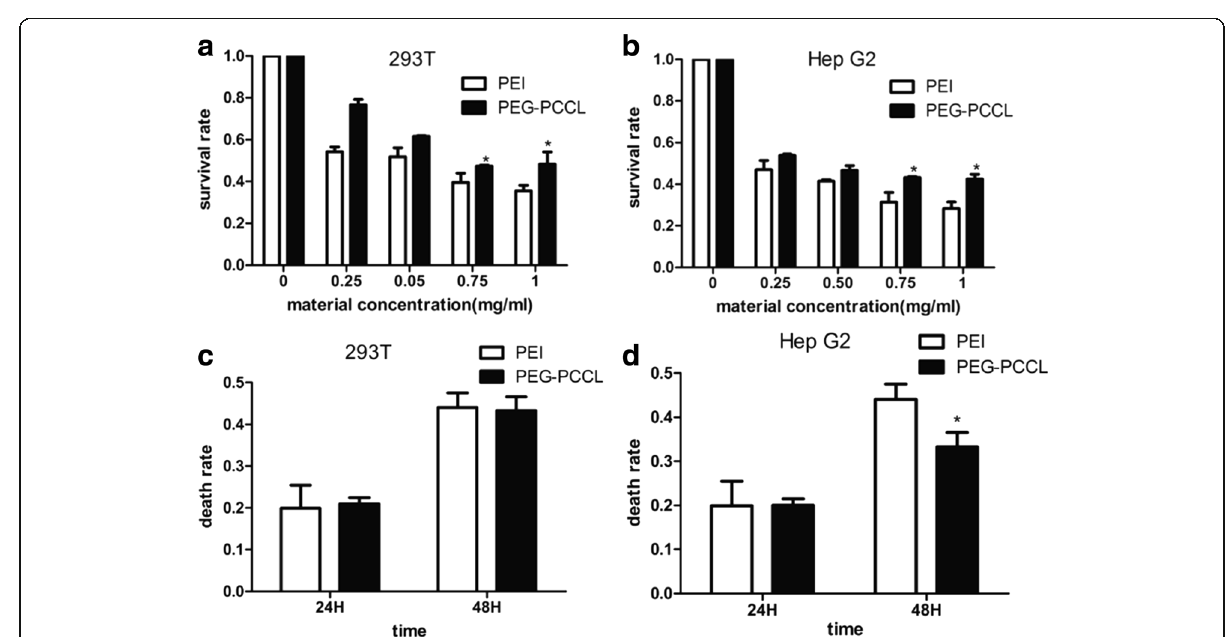
Fig. 3 The cytotoxicity of PEG-PCCL compared with PEI. a , b MTT assay showed the survival rate of 293 T and HepG2 concentration dependently compared with negative controlled group(PEI). c , d LDH leakage assay of 293 T and HepG2 exposing to PEG-PCCL and PEI after 48 h. * P < 0.05 versus PEI group